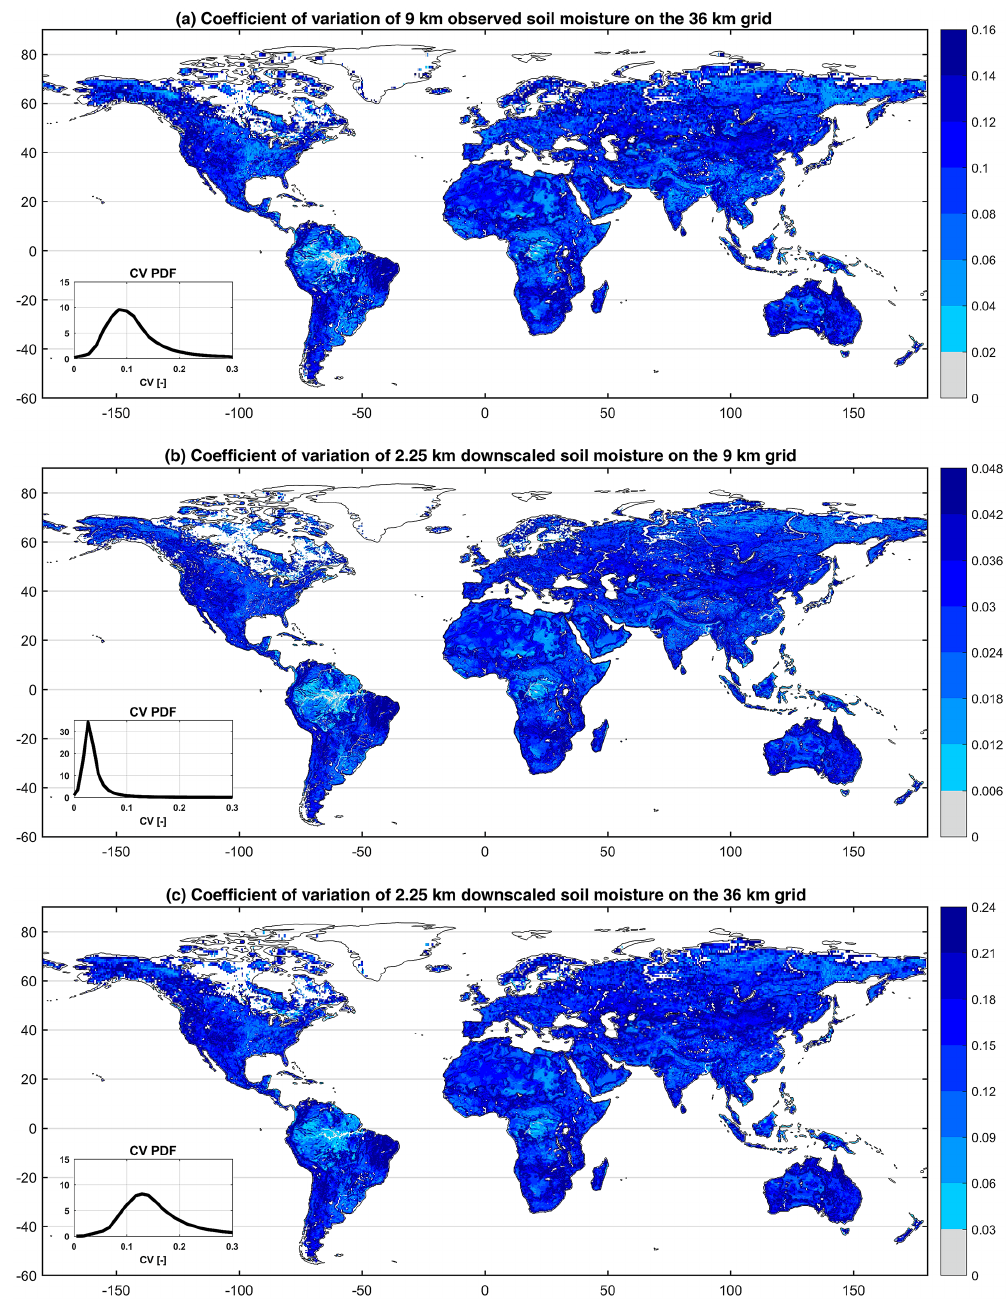
Figure 7. Coefficient of variations of (a) 9km observed soil moisture within each 36km grid pixel, (b) 2.25km downscaled soil moisture within each 9km grid pixel and (c) 2.25km downscaled soil moisture within each 36km grid pixel.